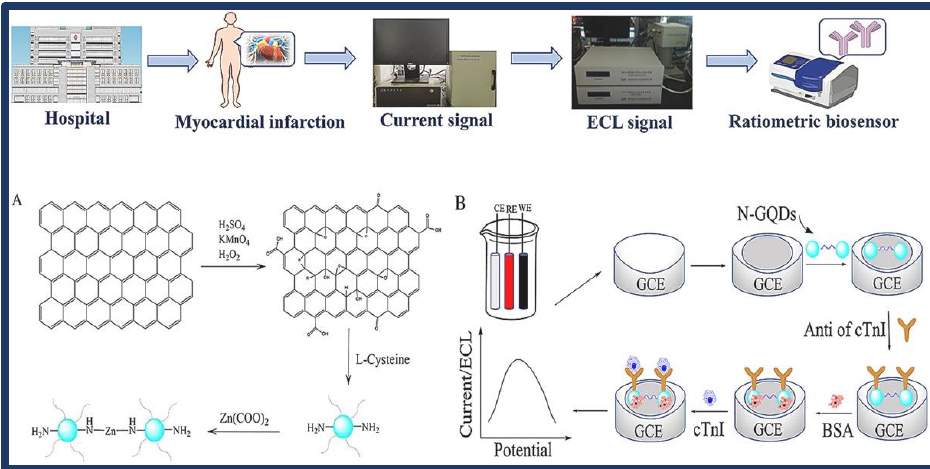
Figure 5. Schematic of the prepared rout of N, Zn-GQDs (A) and the ratiometric biosensor for analysis of cardiac troponin I (B). The electrochemical parameter was −0.6– 0.8 mV, the scanning rate was 0.1 V/s, the condition of electrochemiluminescence (ECL) intensity was the scanning range of −2.0− 0 V in 0.05 M K 2 O 8 S 4 solution and the potential increment of 10 mV. Reprinted from Ref. [67] with permission from Elsevier.